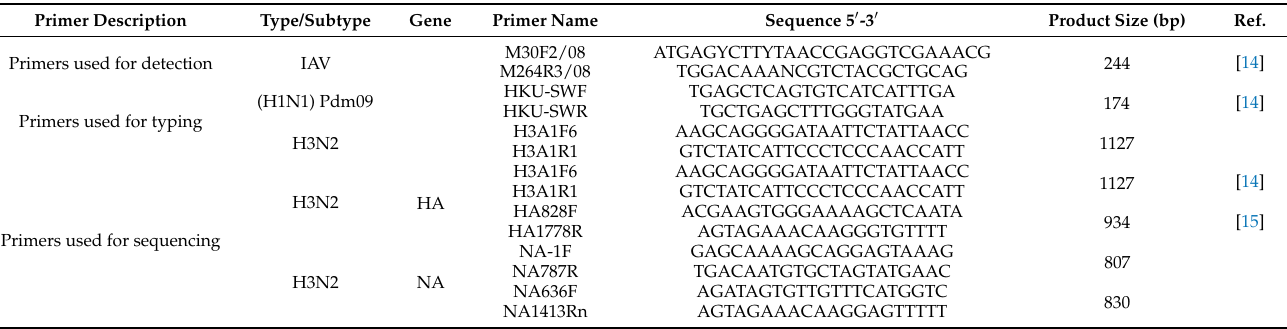
Table 1. List of IAV for the detection, typing (H1N1 and H3N2), and sequencing primers included in this